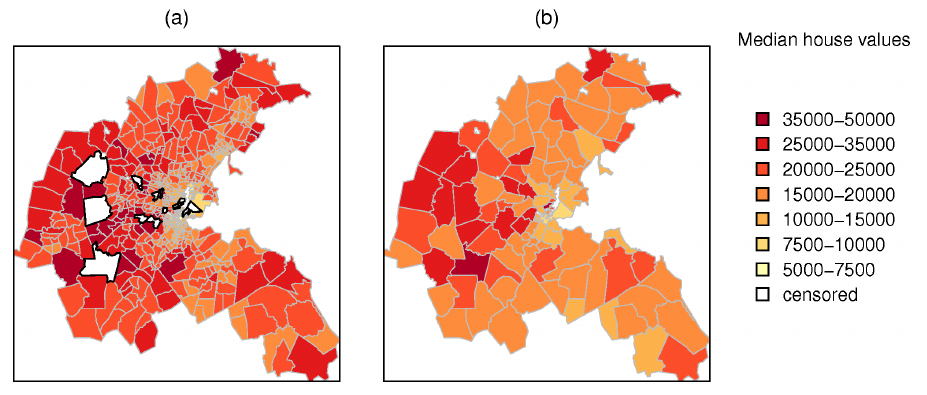
Figure A.4: Median house values (USD 1970): (a) 506 census tracts and (b) 96 approximate TASSIM zones; in panel (a), the censored tracts are shown with black boundaries.